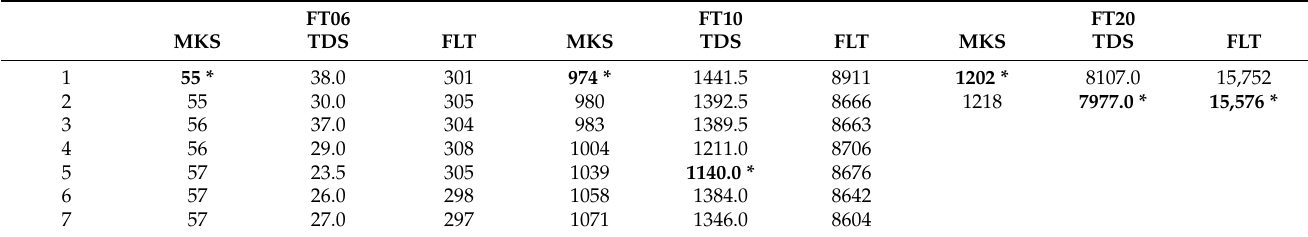
Table A13. Non-dominated solutions obtained by SS/CMOTA for the JSSP instances proposed by